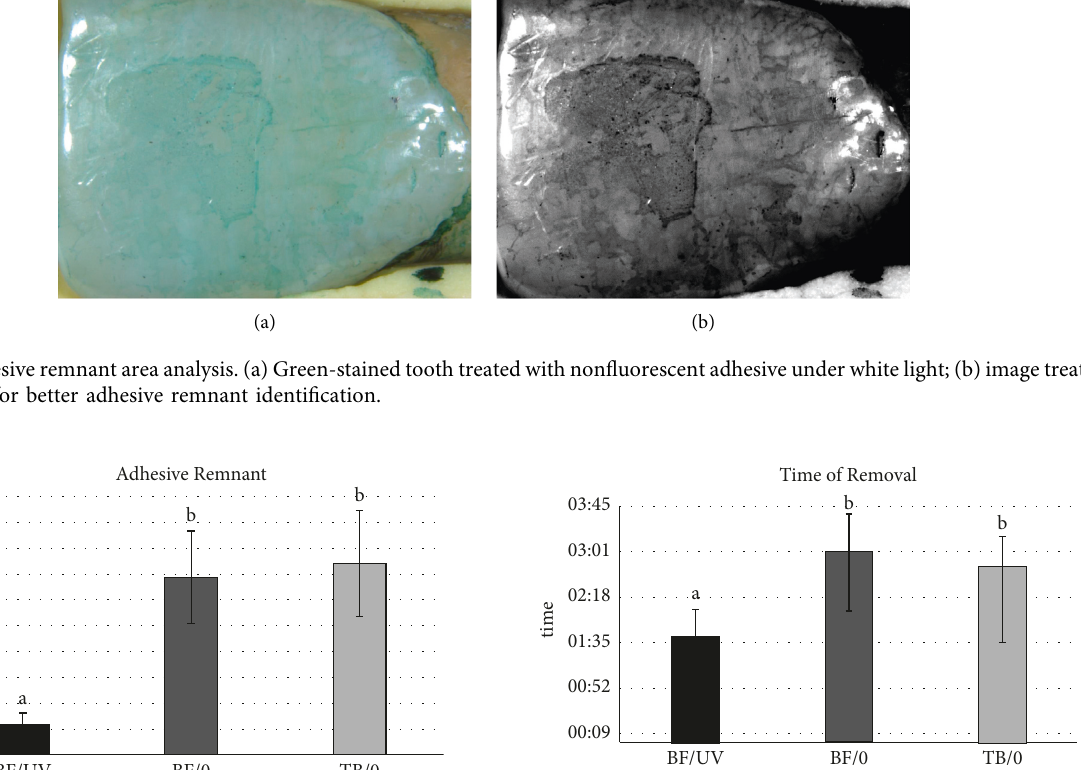
Figure 3: Means (SD) of adhesive remnant percentage for all groups and results of Tukey’s test. Different letters in columns show significant